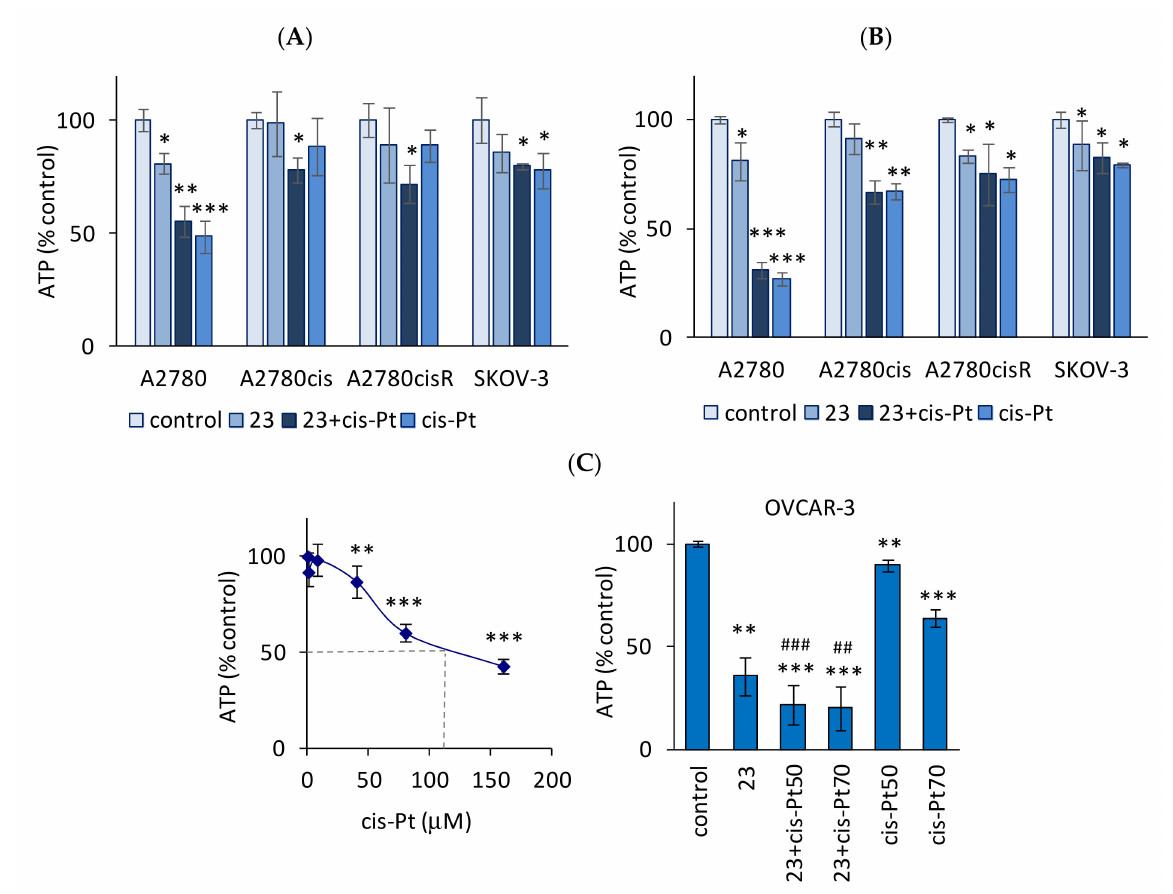
Figure 12. Effect of compound 23 alone and in combination with cisplatin on spheroid viability. Spheroids derived from A2780, A2780cis, A2780cisR cells, and SKOV-3 cells were incubated with compound 23 (40 µ M), cisplatin (10 µ M), or in combination. In the combined treatment, the cells were incubated first with compound 23 (for 3 h) followed by 48 h ( A ) and 72 h ( B ) of the treatment with cisplatin. OVCAR-3 cells ( C ) were resistant to cisplatin (left); therefore cisplatin concentration for combined treatment was 50 µ M and 70 µ M (right). DMF was used as the control (<0.06%, not toxic). The effect of different concentrations of DMF on ATP content is presented in the Supplementary Materials (Figure S12). Cell viability was determined by using a CellTiter-Glo 3D Viability Assay (Promega), based on the luminescent measurement of ATP levels (RLU—relative luminescent units). Data are expressed as a percentage of control values for untreated cells (the mean RLU ± SEM values for A2780, A2780cis, A2780cisR, SKOV-3, and OVCAR-3 cells were respectively 156 ± 9, 146 ± 6, 163 ± 18, 171 ± 25, and 175 ± 31). The mean ± SEM values were calculated for 3–4 experiments. * p < 0.05, ** p < 0.01, and *** p < 0.001, compounds versus control; ## p < 0.01 and ### p < 0.001, combined treatment versus cisplatin (C); Student’s t-test, differences significant for multiple comparisons are shown (Bonferroni